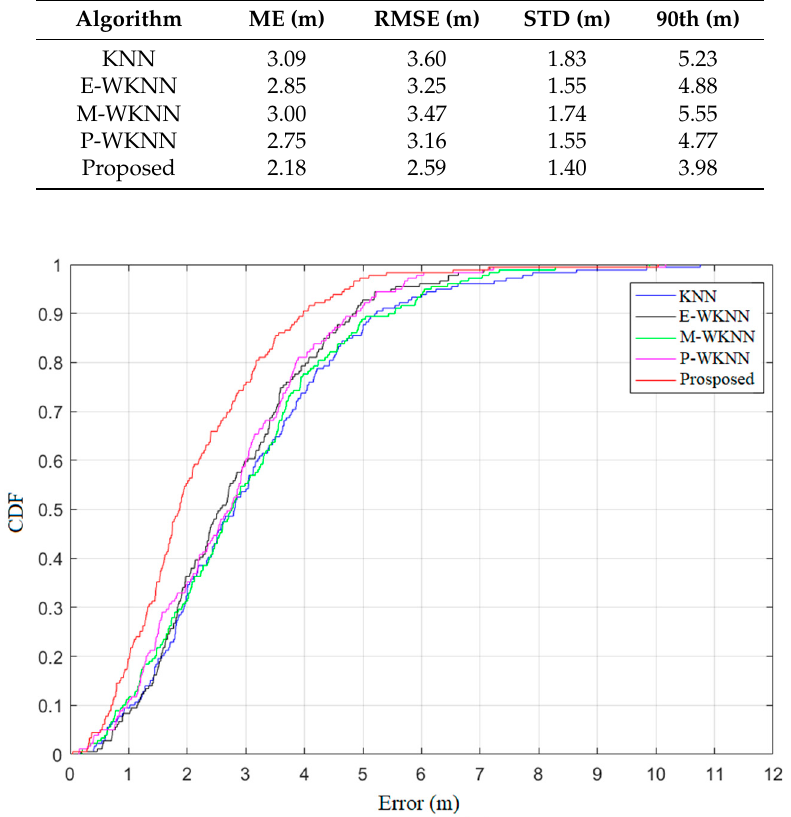
Figure 7. Position errors’ cumulative distribution function (CDF) of the five algorithms.